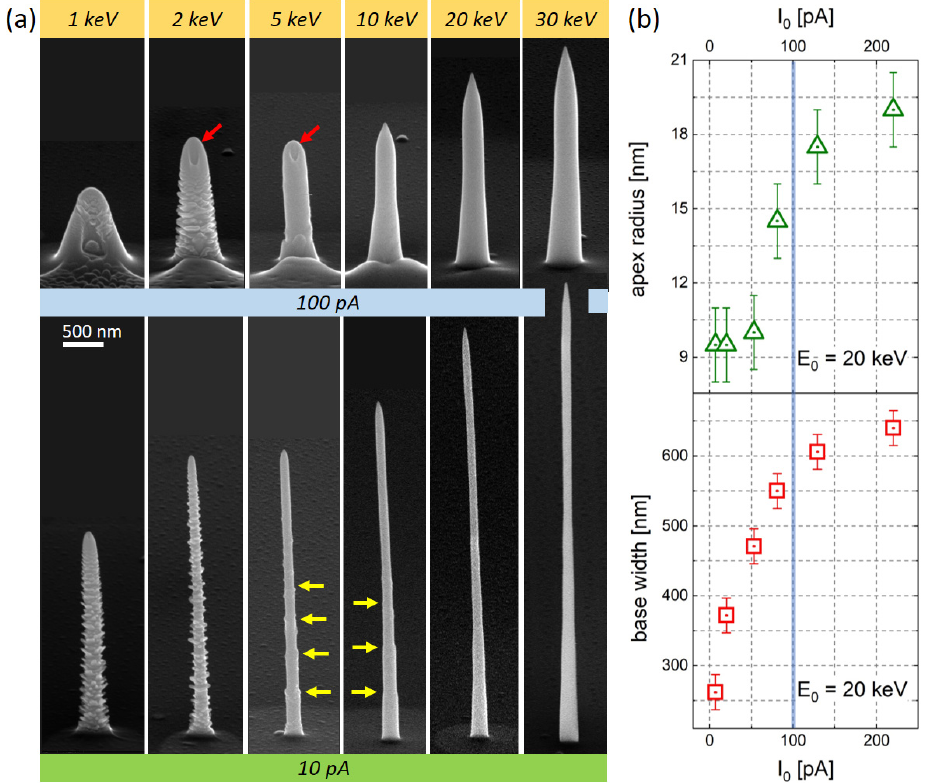
Figure 2. ( a ) Co 3 Fe α -pillar shapes for varying primary electron energies (increasing from left to right), fabricated at high (100 pA, upper row) and low beam currents (10 pA, lower row). The same patterning sequence was used for all fabricated α -pillars with a total exposure time of 750 s, as described in the main text. While yellow arrows indicate beam-blur steps in the morphology, red arrows indicate the indent formation. ( b ) shows the current dependent evolution of apex radii (top triangles) and base widths (bottom squares) for α -pillars produced at 20 keV, which were further used for MFM measurements.